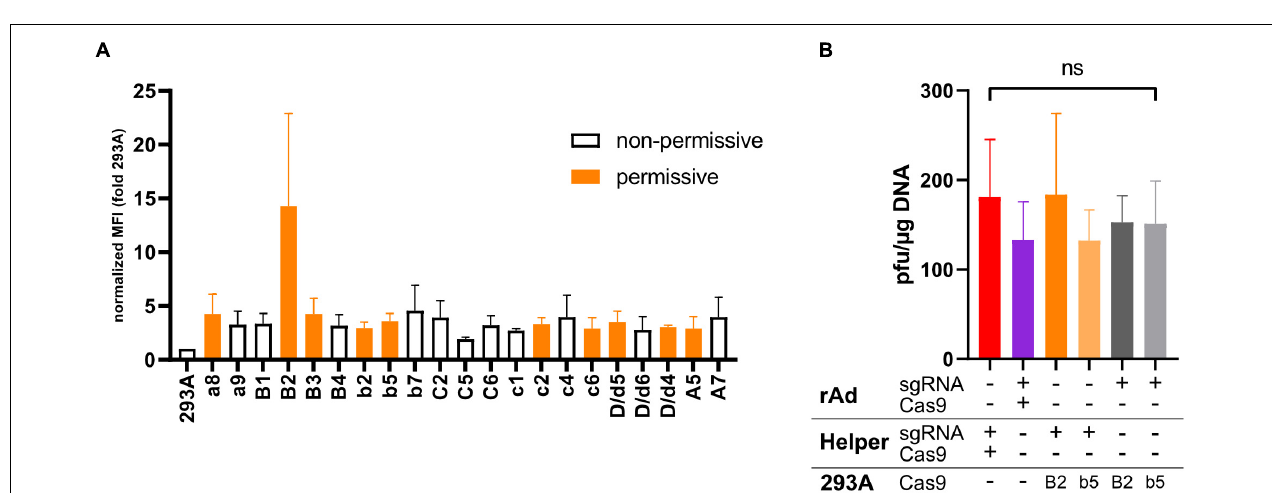
FIGURE 4 | (A) Shown is the fold increase in the mean fluorescent intensity (MFI) in Flag-tag-specific FACS measurements of different 293A-Cas9 clones expressing Flag-tagged Cas9 compared to the parental 293A signal. Data shown represent the mean of two independent experiments, with error bars indicating the range of measurements. All presented clones were also checked for CTR competency of rAd rescue by co-transfecting of pBWH-C5-mChe and pAR-gRNA-Ex. Clones that appeared to be permissive for rAd rescue based on two experiments are indicated by orange bars, while the white bars indicate clones, which appeared to be non-permissive in at least one experiment. (B) Comparison of different approaches for supplying necessary components for CRISPR/Cas9-mediated CTR. Co-transfection of helper plasmid(s) (Helper) expressing sgRNA and Cas9 protein with the construct carrying the ACT flanked rAd bacmids (rAd, red bar, this approach was applied for most of the experiments described in the manuscript) was compared to combination of all CTR components in one construct coding for the rAd genome and all necessary CRISPR/Cas9-components in the vector backbone (purple bar); the Cas9 is delivered by constitutive expression in the cell line